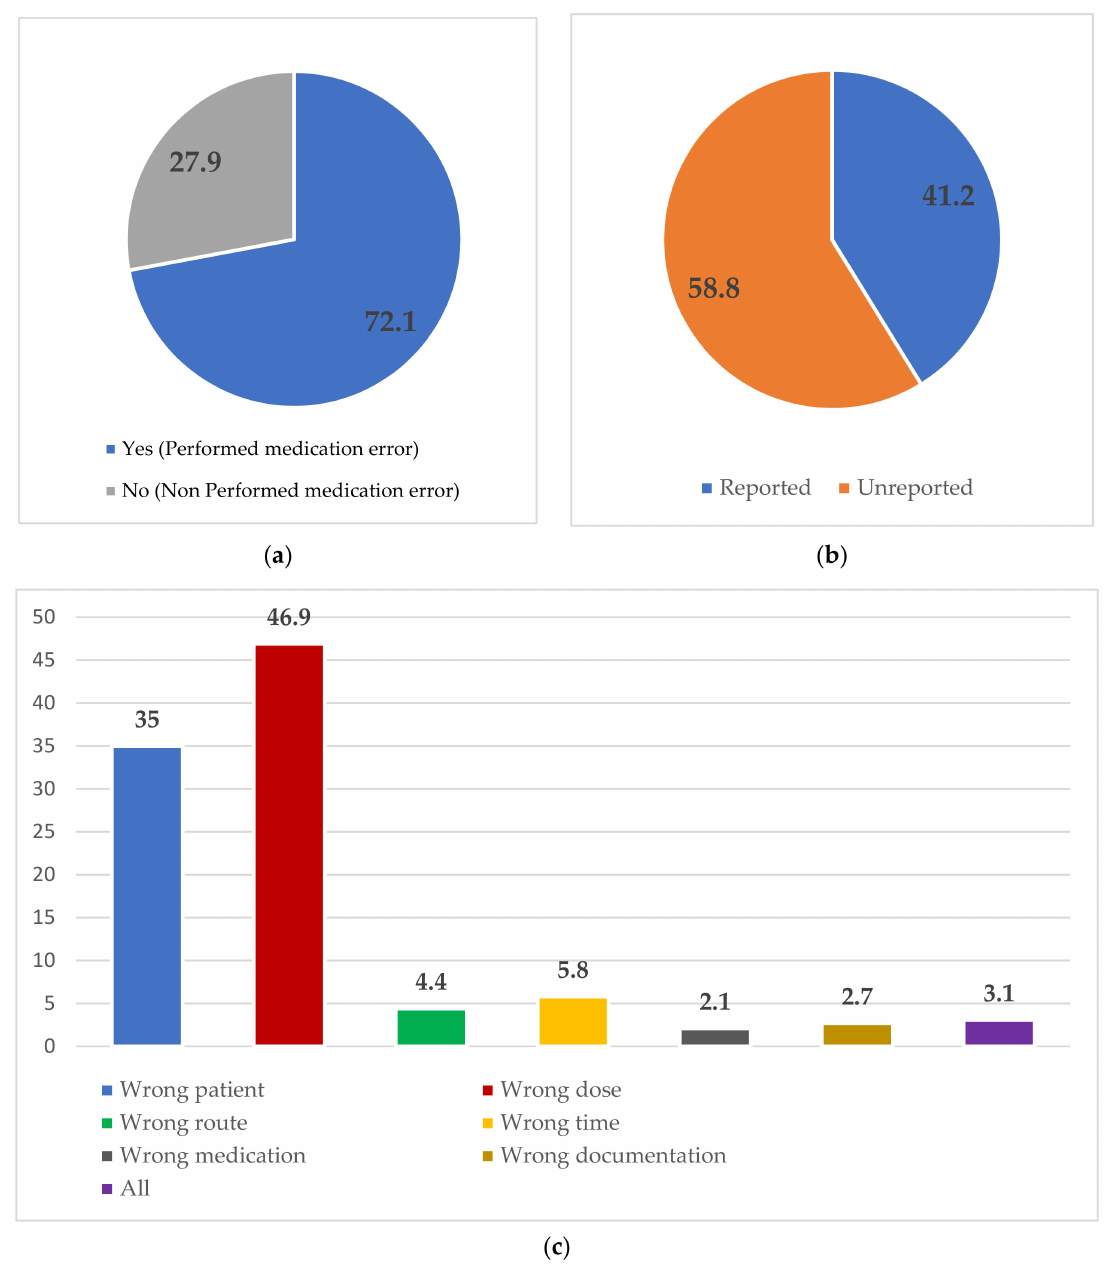
Figure 1. Distribution of medication errors (reported and unreported) ( a ) prevalence of medication error among the nurses; ( b ) prevalence of the reported medication error; ( c ) type of medication